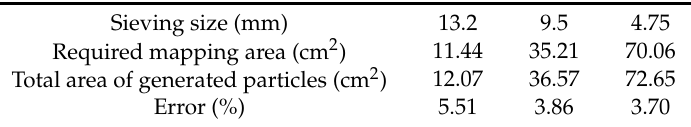
Table 4. Summaries of the virtual